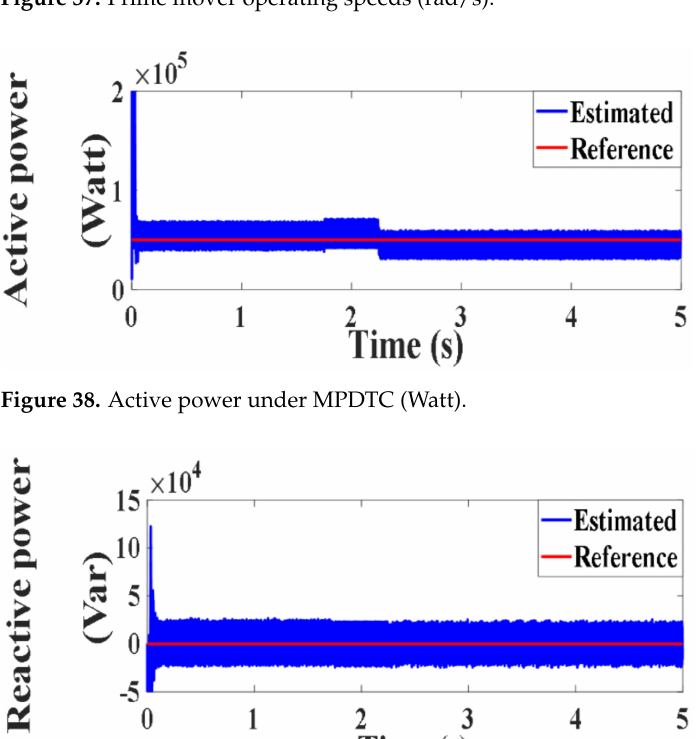
Figure 37. Prime mover operating speeds (rad/s).